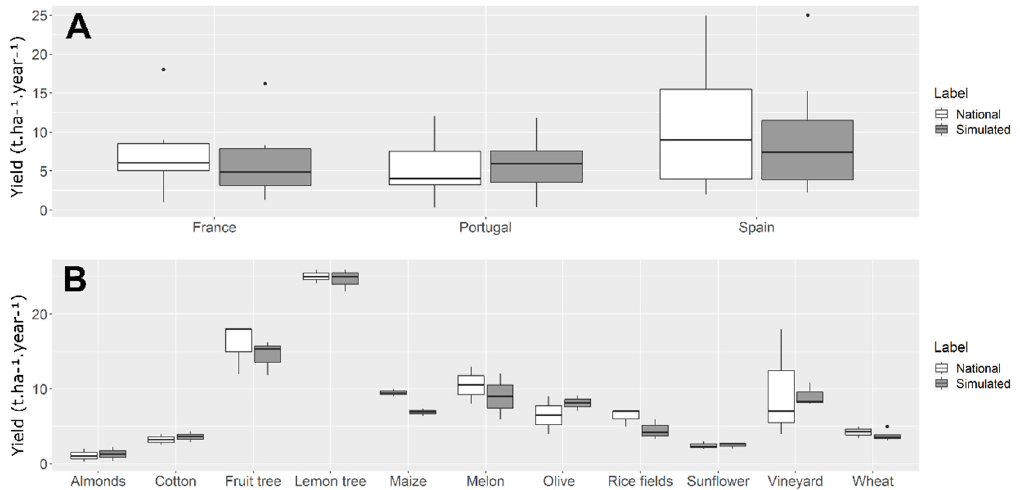
Figure 11. Boxplot of annual national and AC simulated crop yield values (AC: additional calibration ( A ) by country; ( B ) by crops. AC simulated crop yields are the interannual average from 2000 to 2010.